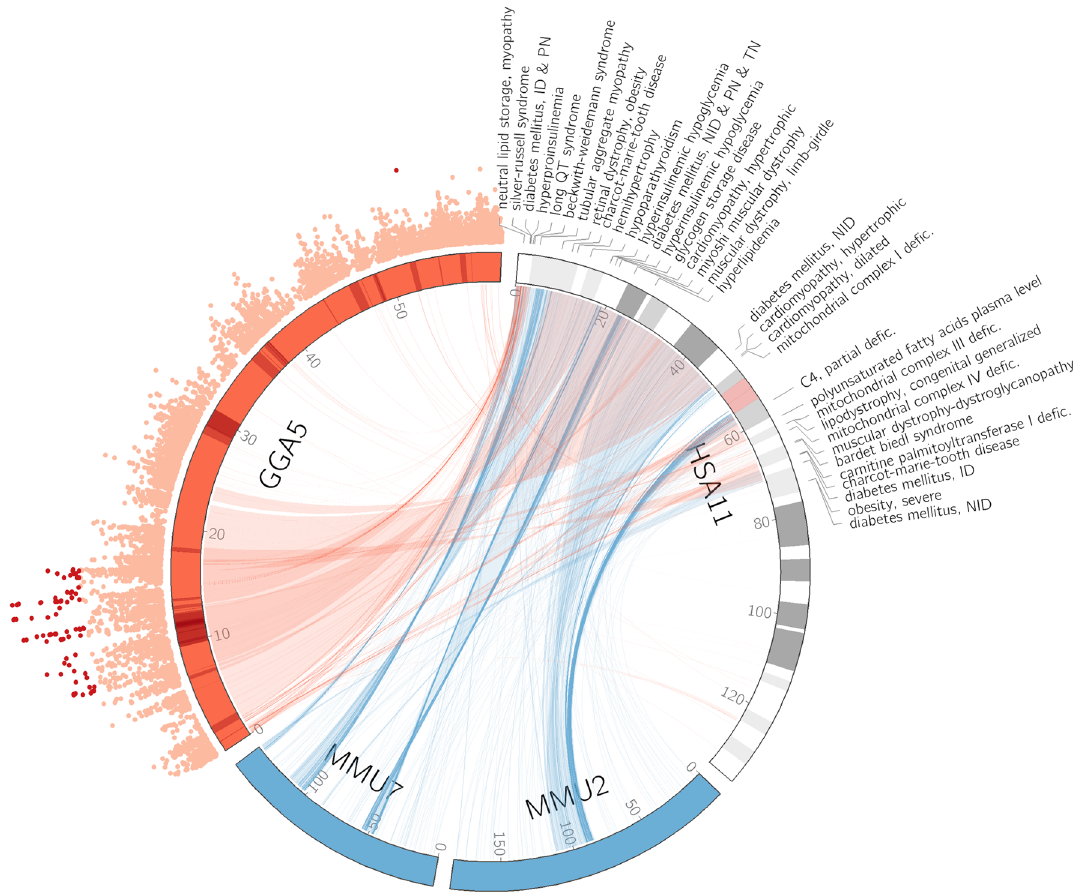
Figure 4. Conserved synteny between chickens and humans. The wooden breast QTL-rich region of chicken chromosome 5 (GGA5) has highly conserved synteny with human chromosome 11 (HSA11),